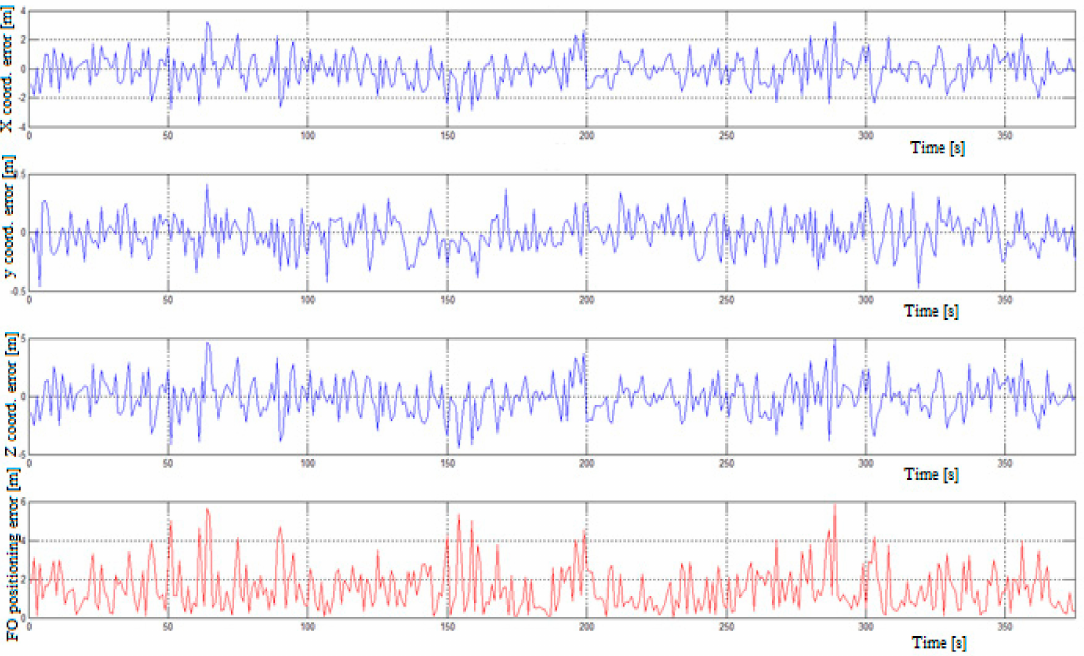
Figure 4. FO positioning error if k = 0.1 and D = 10.0